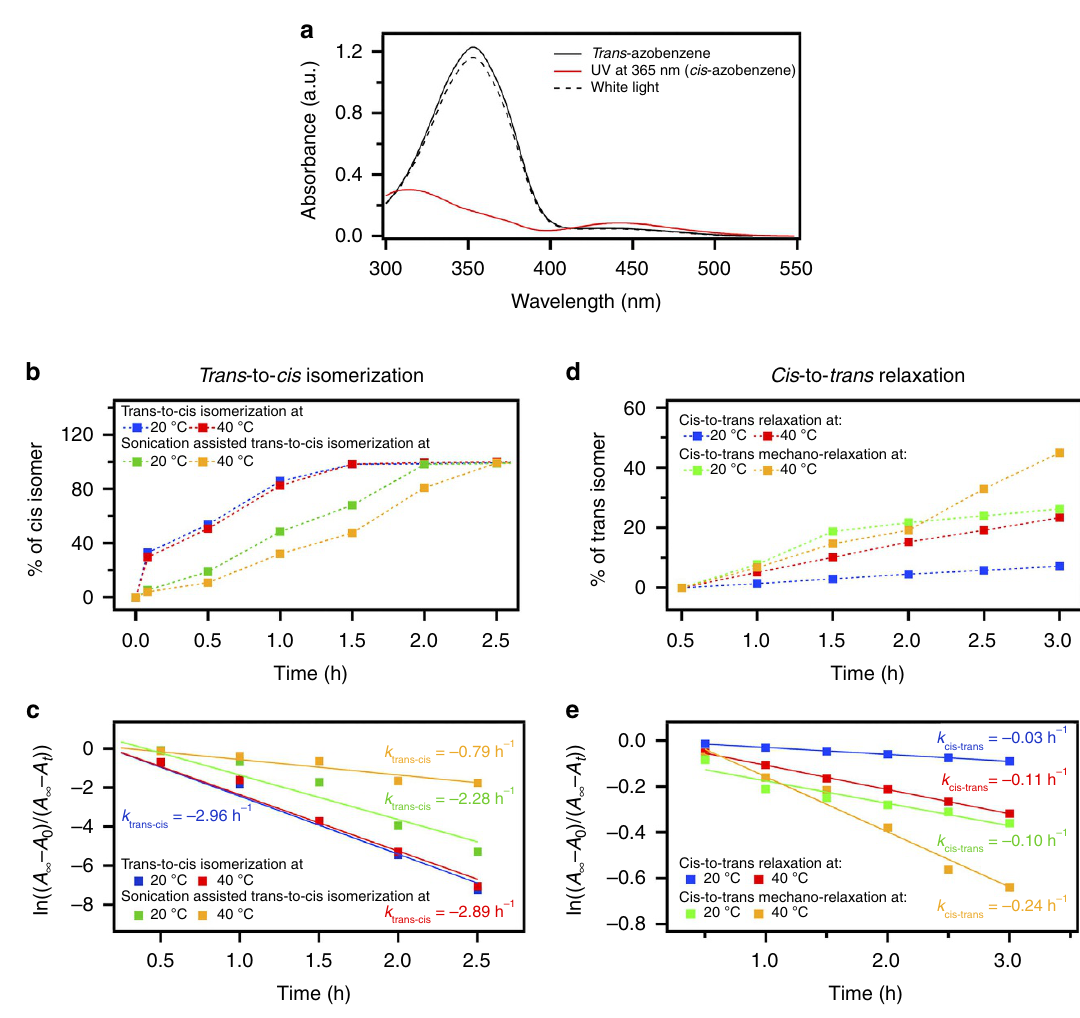
Figure 2 | Spectroscopic characterization of trans -to- cis isomerization and cis -to- trans relaxation. ( a ) UV-ndash;visible spectra of 4-(decyloxy) azobenzene in NMP (1.62mM) showing the disappearance of the 353-nm band and an increase of the 442-nm band for 365-nm irradiation. The solid black line corresponds to the parent trans -4-(decyloxy)azobenzene spectrum, the red line represents a typical spectrum of a solution irradiated with UV light ( cis -4-(decyloxy)azobenzene), whereas the black dashed line corresponds to a cis -4-(decyloxy)azobenzene solution irradiated with visible light (thus re-transformed into trans -4-(decyloxy)azobenzene). ( b ) Conversion percentage from trans to cis as a function of UV irradiation time at 20 and 40 (cid:2) C. ( c ) First-order kinetic plots and rate constants ( k trans – cis ) for trans -to- cis isomerization at 20 and 40 (cid:2) C. ( d ) Conversion percentage from cis to trans as a function of time at 20 and 40 (cid:2) C. ( e ) First-order kinetic plots and rate constants ( k cis – trans ) for the cis -to- trans relaxation at 20 and 40 (cid:2) C. ( b – e ) Reference samples prepared without sonication: blue (20 (cid:2) C) and red (40 (cid:2) C); sonicated samples: green (20 (cid:2) C) and orange (40 (cid:2)